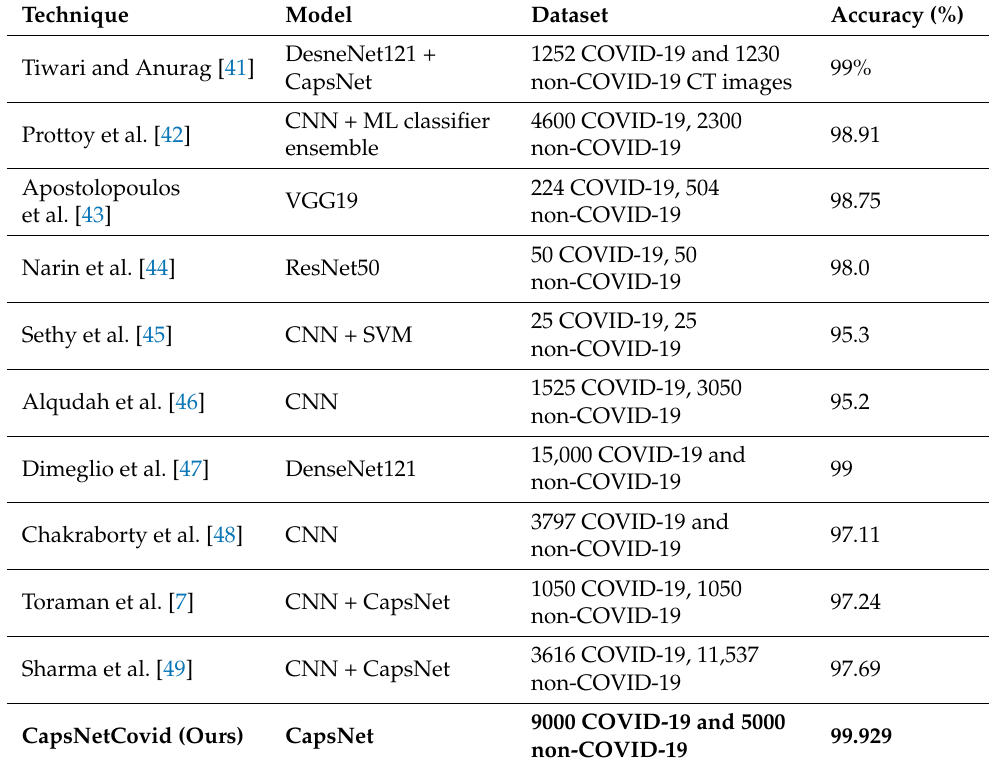
Table 16. CapsNetCovid versus existing COVID-19 diagnosis techniques for binary classification.